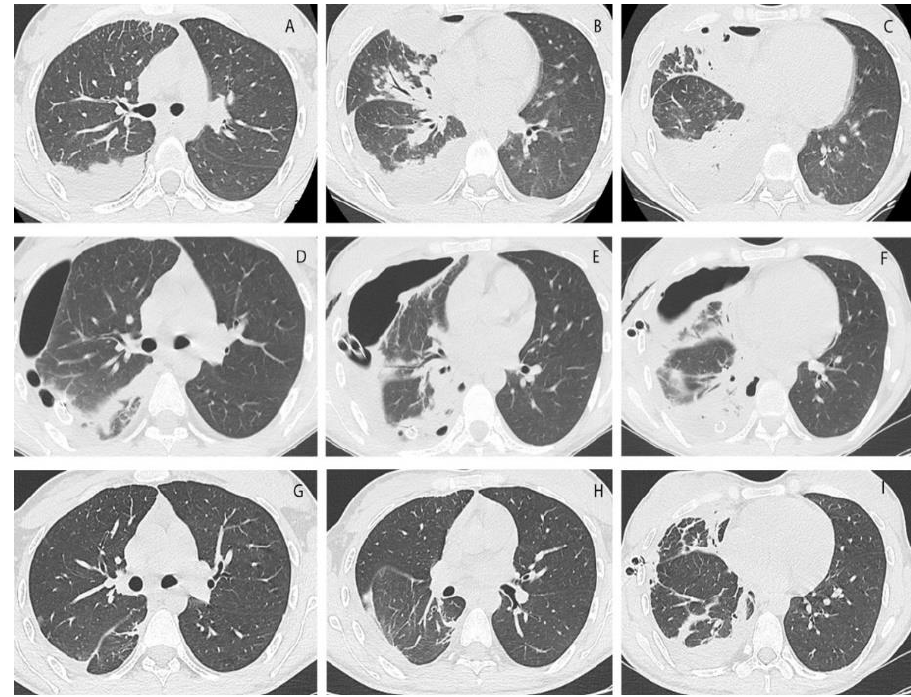
Figure 2. ( A – C ): Pre-operative CT scan; ( D – F ): first day post-operative CT scan, needed for the patient’s clinical conditions; ( G – I ): five days post-operative CT scan. In the last row, the drainages appear in a different position than the middle row because they were dislocated due to an abrupt movement of the patient. They were subsequently removed on that same day.